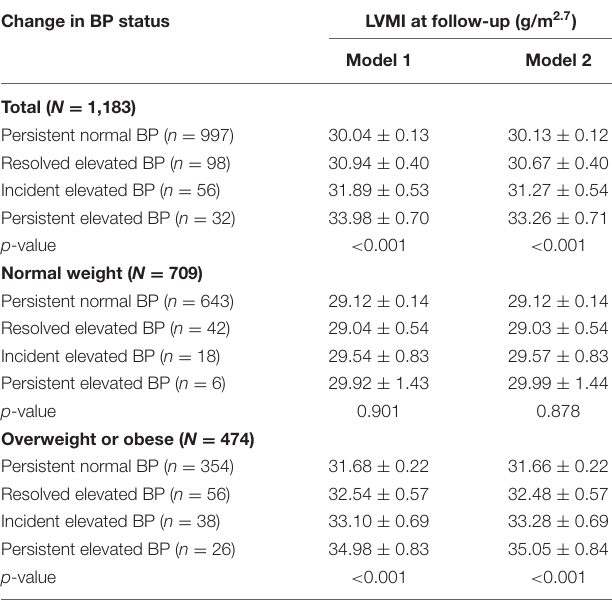
TABLE 2 | LVMI at follow-up across four groups of the change in BP status in the total sample and stratified by weight status.